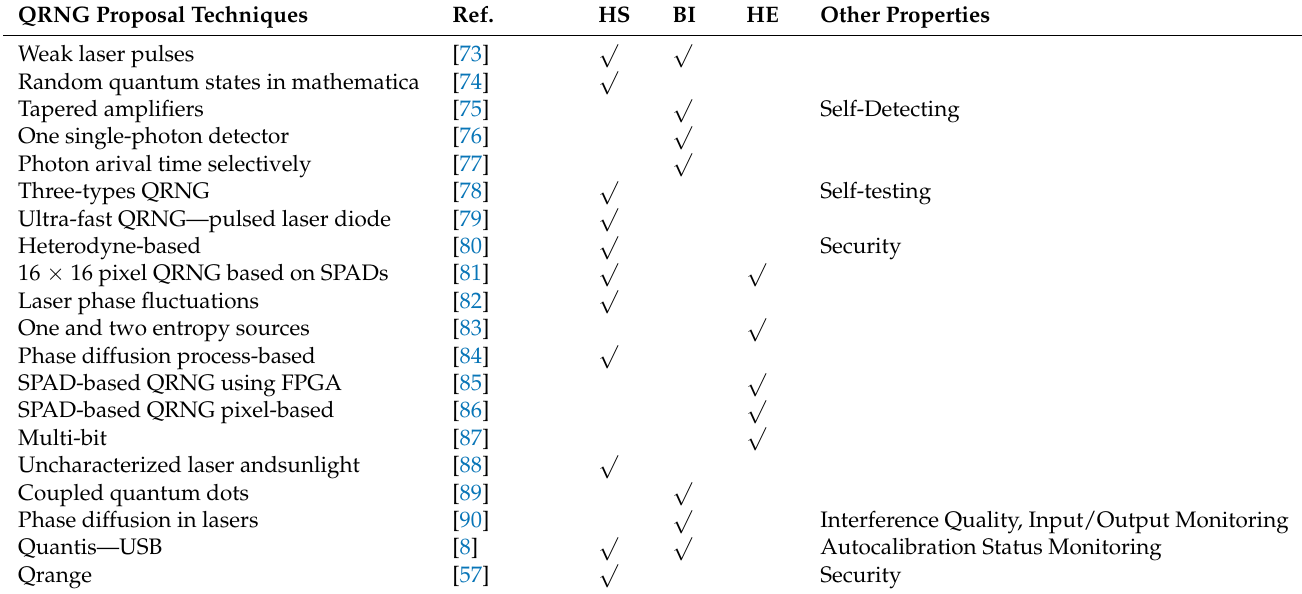
Table 5. Literature review of